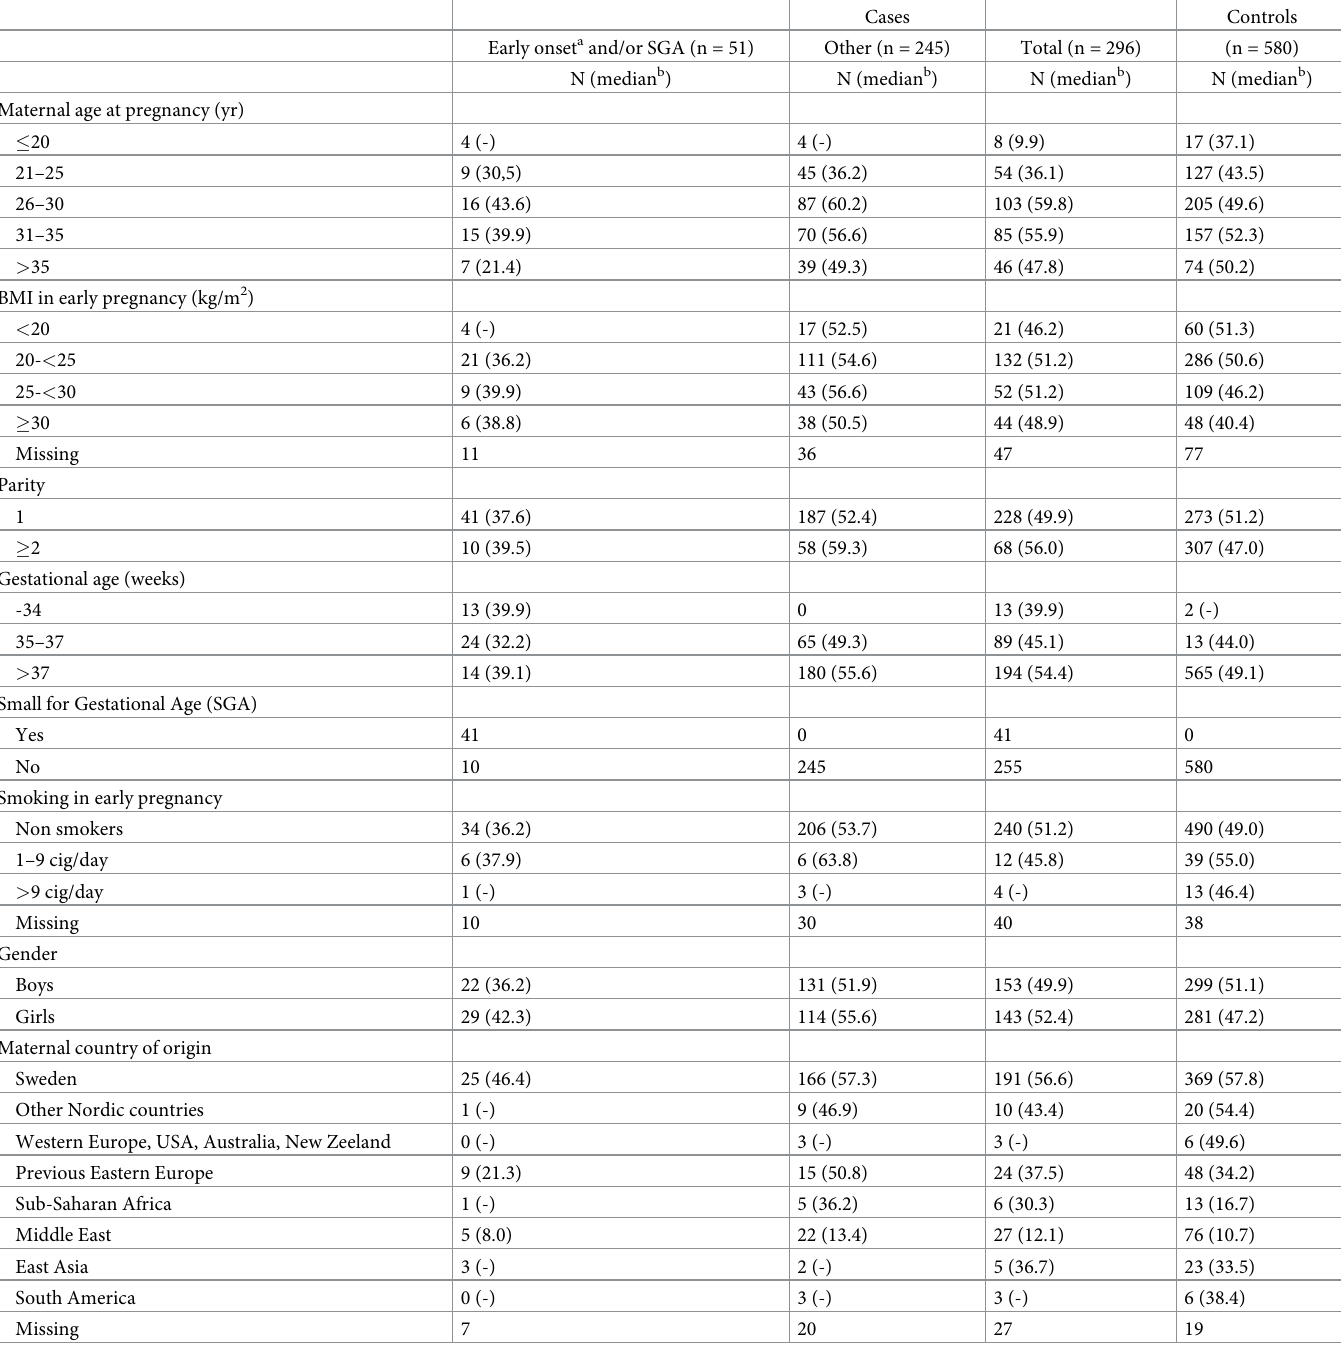
Table 1. Background characteristics among 296 preeclampsia cases and 580 controls. In addition, the cases are divided into two groups. Numbers and within brackets median levels of vitamin D (25-hydroxyvitamin D3, nmol/L) are shown b